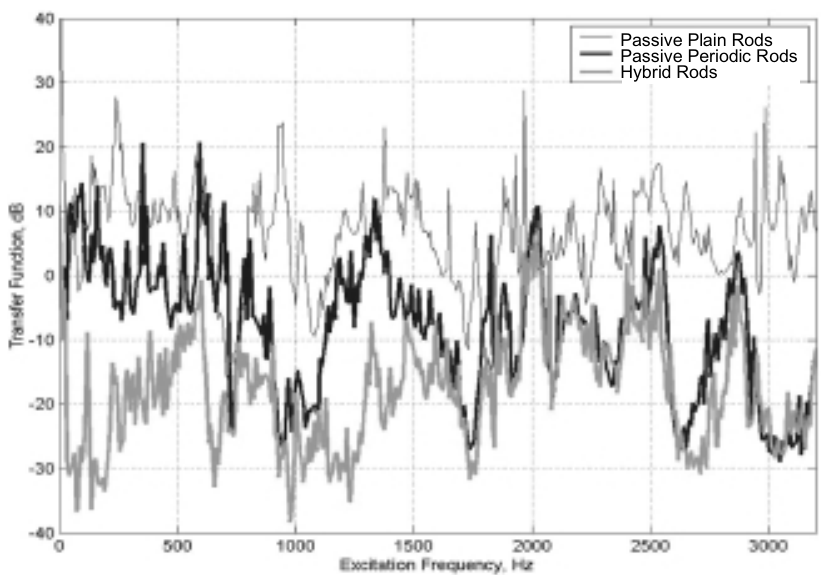
Fig. 13. The transfer function in case of collocated sensor/actuator arrangement with broadband excitation from the motor.